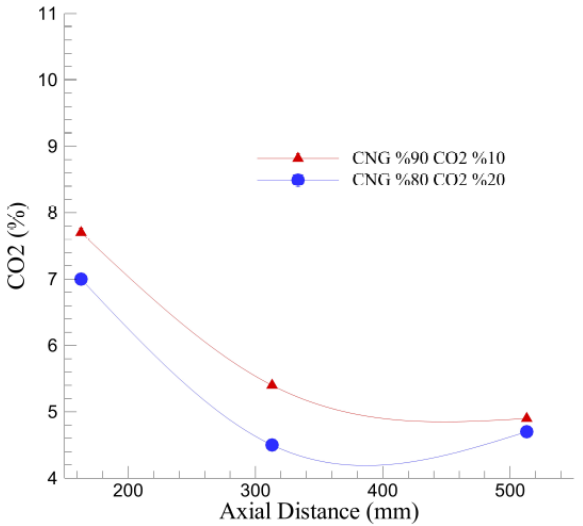
Figure 11: Axial CO 2 concentration profiles (Swirl number: 0.4, Equivalence ratio: 0.9).